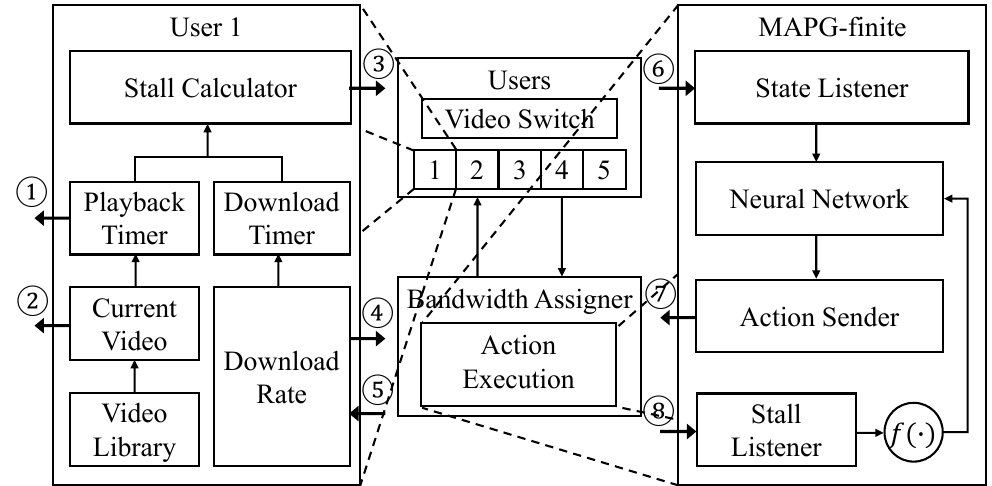
Figure 5. The implementation of our testbed, where the blocks on the left and right show the internal architectures of an individual user module and the MAPG-finite engine, respectively. The four state variables ( v ( t ) , d ( t ) , z ( t ) , c ( t )) are collected/calculated by each user and delivered to the